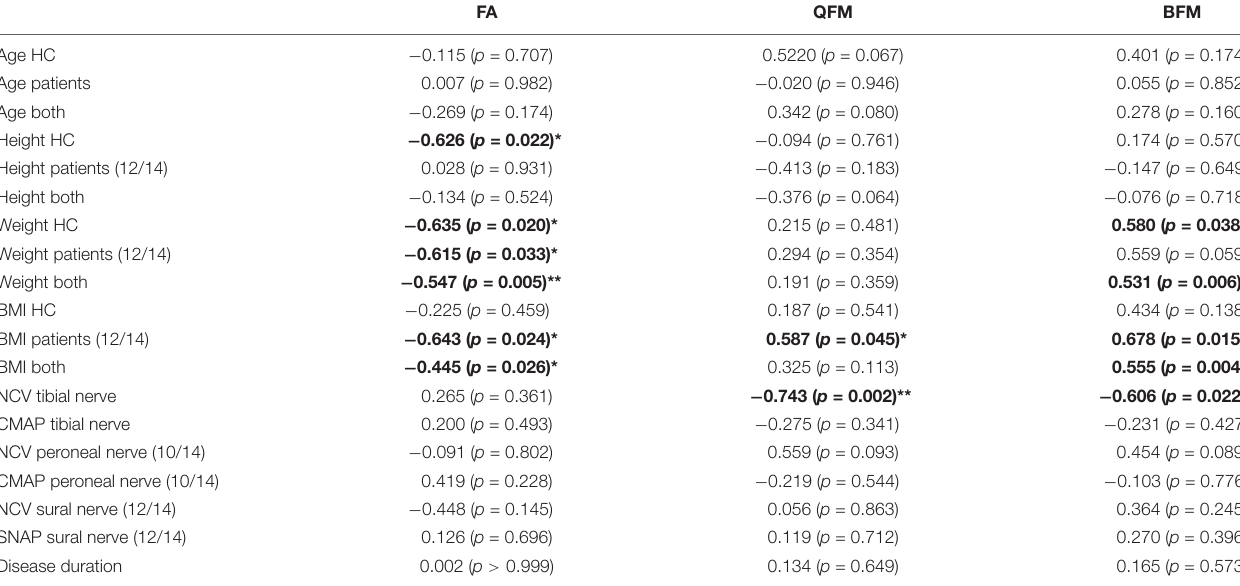
TABLE 3 | Correlations between the collected demographic and clinical data and the obtained imaging